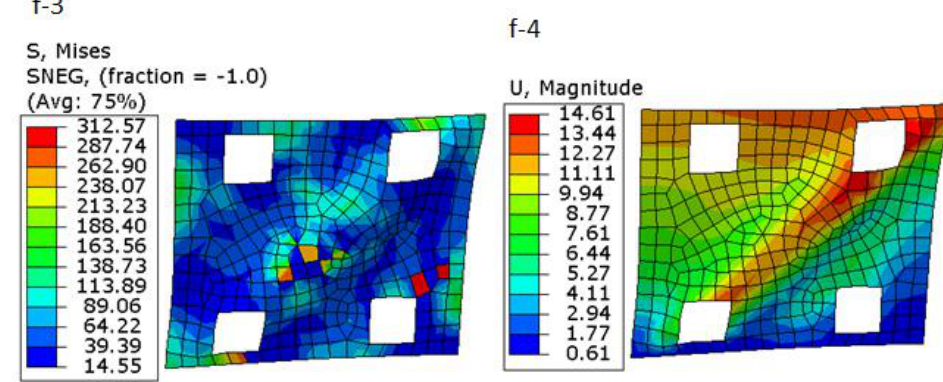
Figure 19. Von Mises stress and displacement for concrete part ( f-3 ) stress and ( f-4 ) displacement.